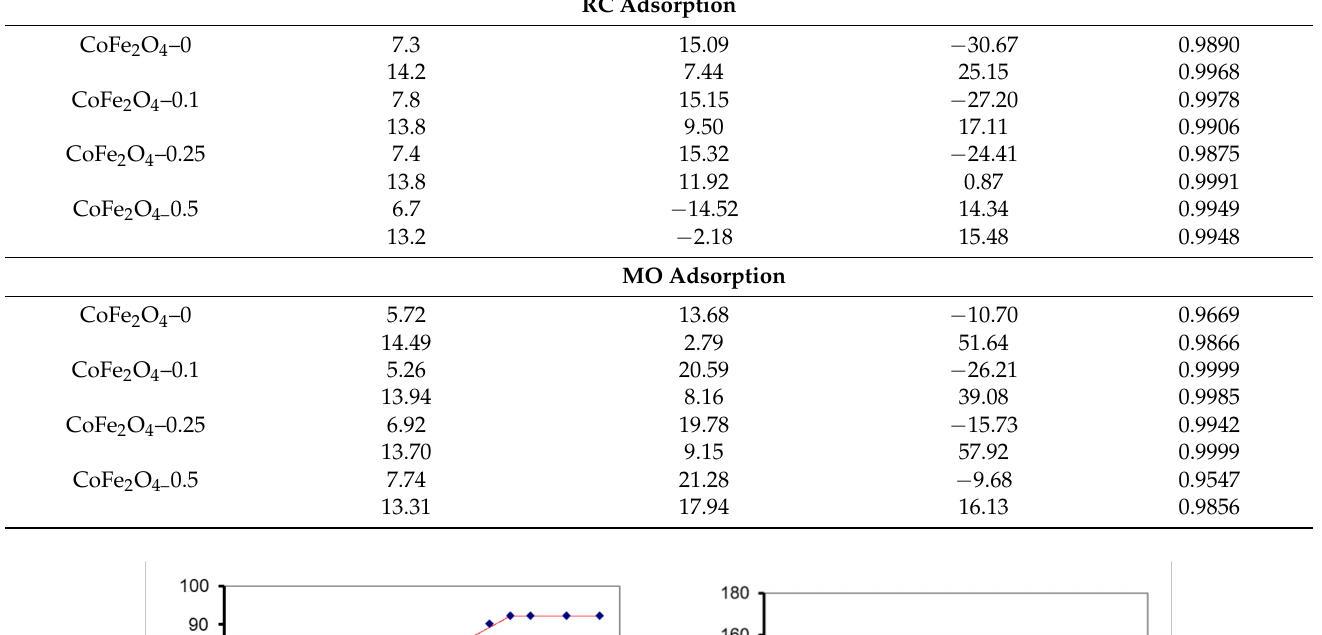
Table 5. Kinetic parameters obtained from the fitting of the experimental data with the intraparticle diffusion model. Sample